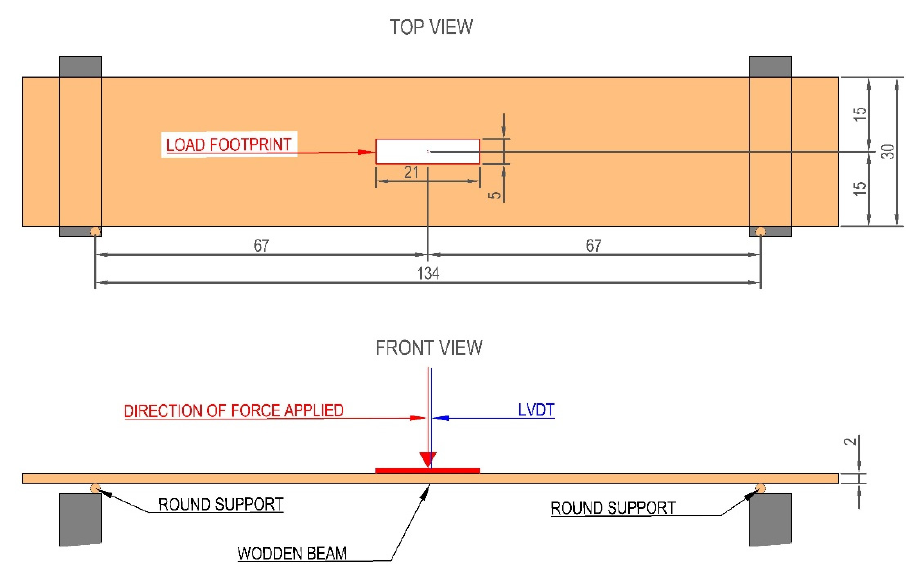
Figure 2. Schematic diagram of the loading for BEAM 1, all dimensions are in cm (Source: Own compilation).